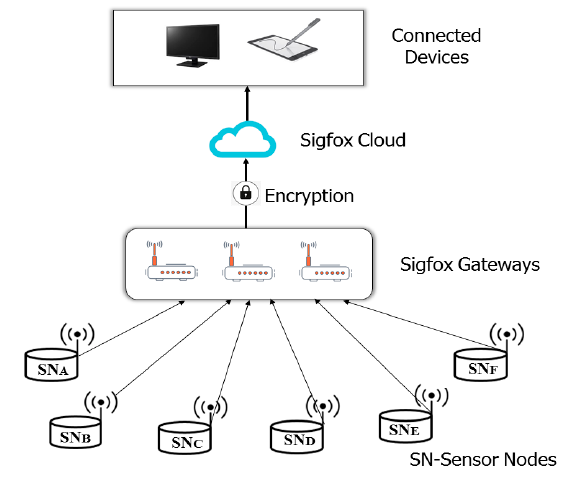
Figure 2. Architecture of a typical SigFox network [49].